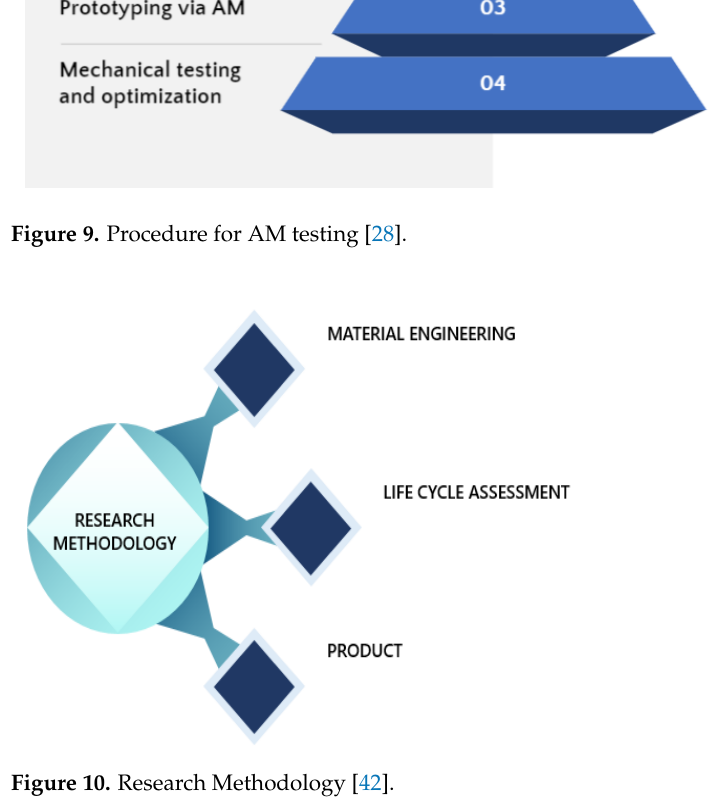
Figure 10. Research Methodology [42].